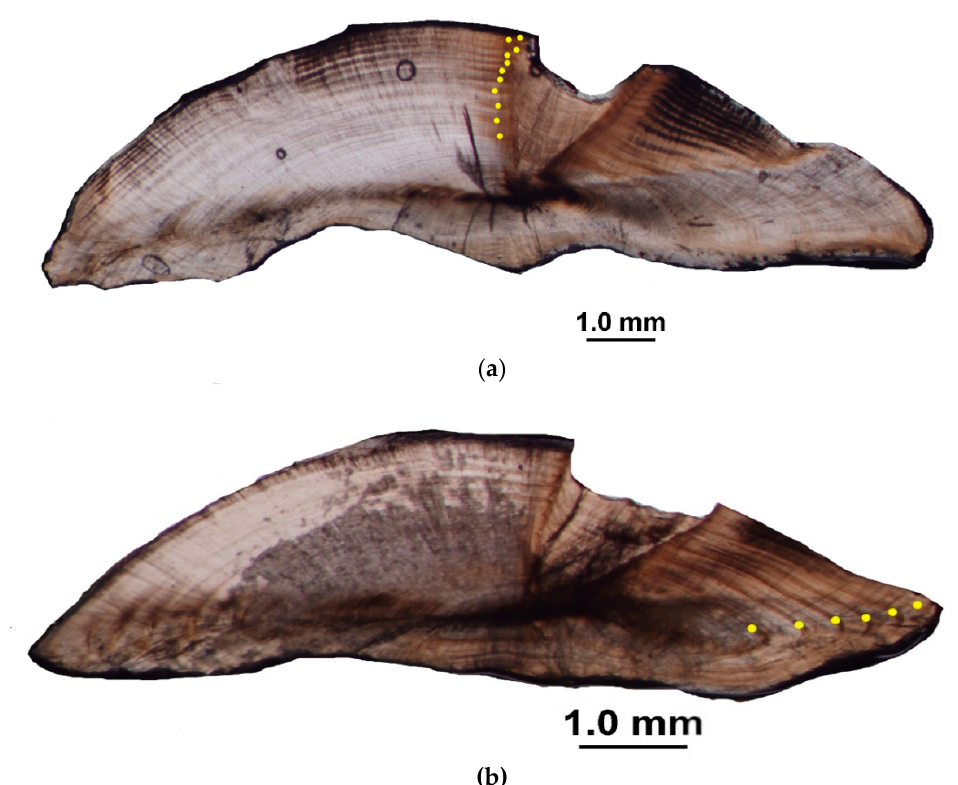
Figure 1. Sections from otoliths of ( a ) margate ( Haemulon album ), 586 mm total length (TL), 11 ‐ yr; ( b ) black margate ( Anisotremus surinamensis ), 357 mm TL, 6 ‐ yr.